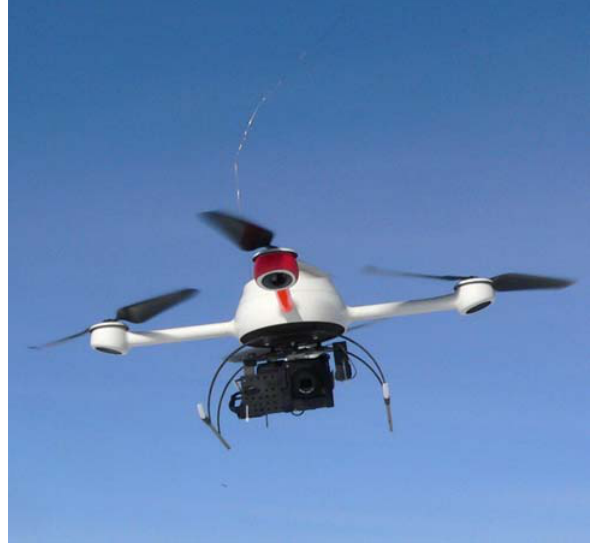
Figure 1. MD4-200 Unmanned Aerial Vehicle during snow measurements in spring 2009 with the Ricoh GR Digital II